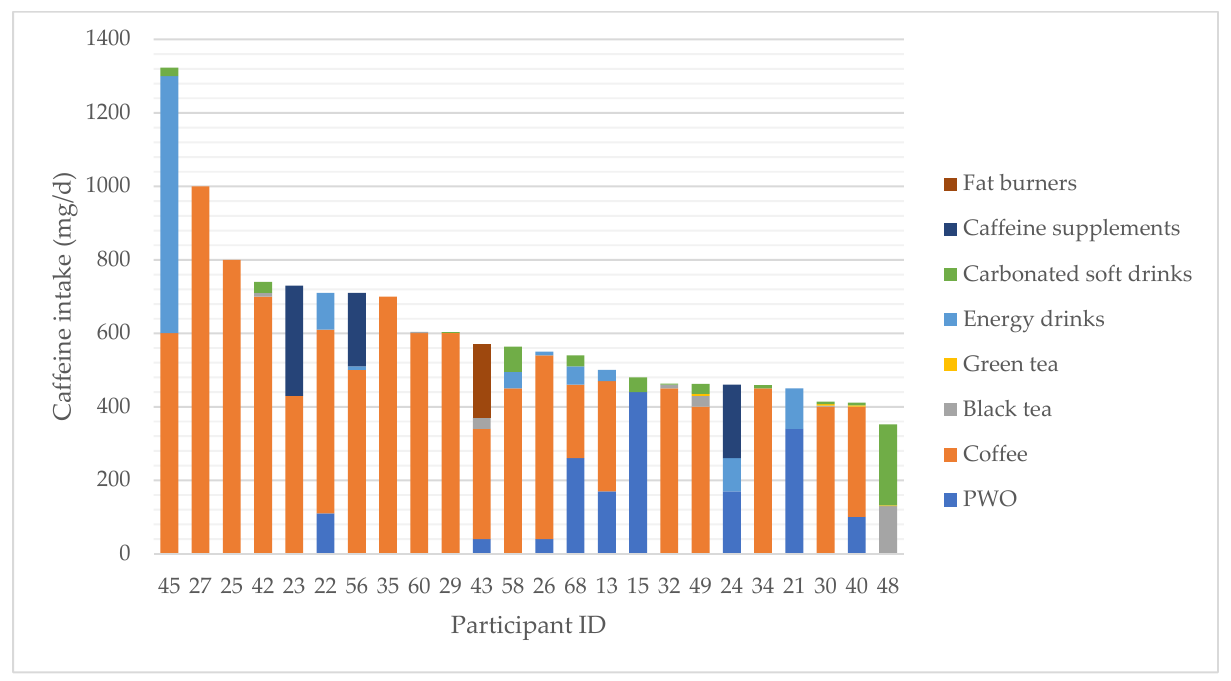
Figure 1. Individual caffeine intake by source for participants exceeding the presumed safe level (for caffeine, an intake up to 400 mg per day from all sources does not give rise to safety concern in adults). For children and adolescents, an intake of 3 mg/kg body weight per day may serve as a basis to derive intake of no concern for this subgroup [16]. The last bar is showing intake from an adolescent; the other bars represent intake data for adult men (18–35 years). PWO: Pre-workout products.